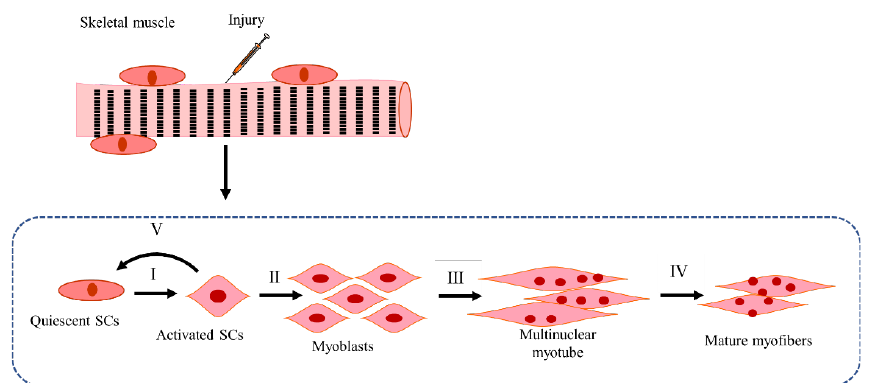
Figure 2. SC activation, myoblast proliferation, differentiation and fusion, and the myotube matura- tion in CTX-induced injury models. ( I ) SC activation. In the damaged muscle, the quiescent SCs are activated to repair the skeletal muscle. Conversion of n-6 to n-3 polyunsaturated fatty acids (PUFAs), Salvador, testosterone, upregulation of Insl6, and so on, promote, while the lack of Nrf2, LCN2, and miRNA-501 inhibit the activation of SCs. ( II ) Myoblast proliferation. Activated SCs begin to proliferate and become myoblast. FGF2, RING finger protein13 (RNF13) derived from macrophages, Sod1/Cat, lack of p21, and so on facilitate, while FOXO1/p57/Gadd45 α and CaMKK2/AMPK, lack of G α i2 and H19/Igf2, etc., inhibit myoblast proliferation. ( III ) Myoblast differentiation and fusion. The expended myoblasts experience differentiation and fuse with other muscle fibers to form multinuclear myotubes. Lack of SLK and APOBEC2, upregulation of miR-206, miR-378, MMP-13, and Ccndbp1 enhance; Parkin, tension, Rbm24, and Hsp70 deficiency inhibit the capacity of myoblast differentiation. Lack of ANO5, HMGR, BAI3, and miR-188, and so on, inhibit, upregulation of Nox4/ROS, PLD1, Mustn1, and TRPV1 stimulate myoblast fusion. ( IV ) Maturation of myofibers. Lack of Dcx, PTEN, and desmin influence the myofiber maturation. ( V ) Self-renewal of SCs. The activated SCs proliferate to replenish the SC pool of the skeletal muscle. In this process, Angiotensin II, lack of mTORC2, AIF, SelN, and Notch1/Notch2 impair, while Lgr5, laminin-111, lack of PKC θ , Rb1, and Pax7 acetylation stimulate SC self-renewal or SC pool